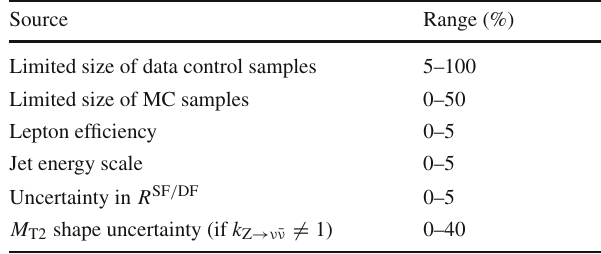
Table 3 Summary of systematic uncertainties in the Z → ν ¯ ν back- ground prediction, together with their typical size ranges across the search